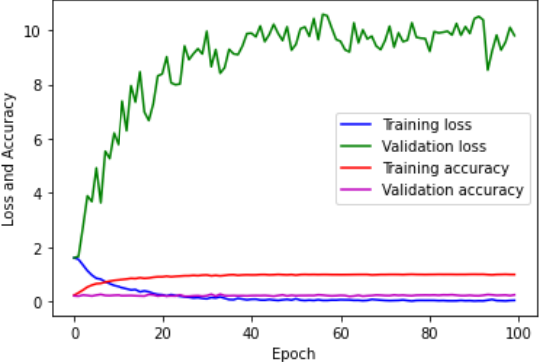
Figure 7. Error/accuracy plot for training/validation sets for the hologram dataset.